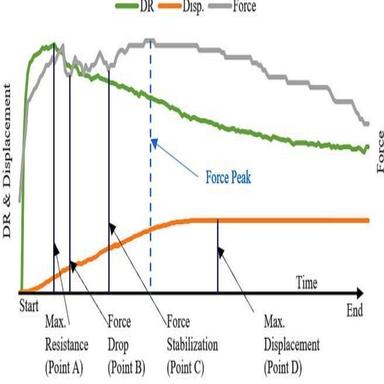
Typical weld with marked extracted features and the force peak.